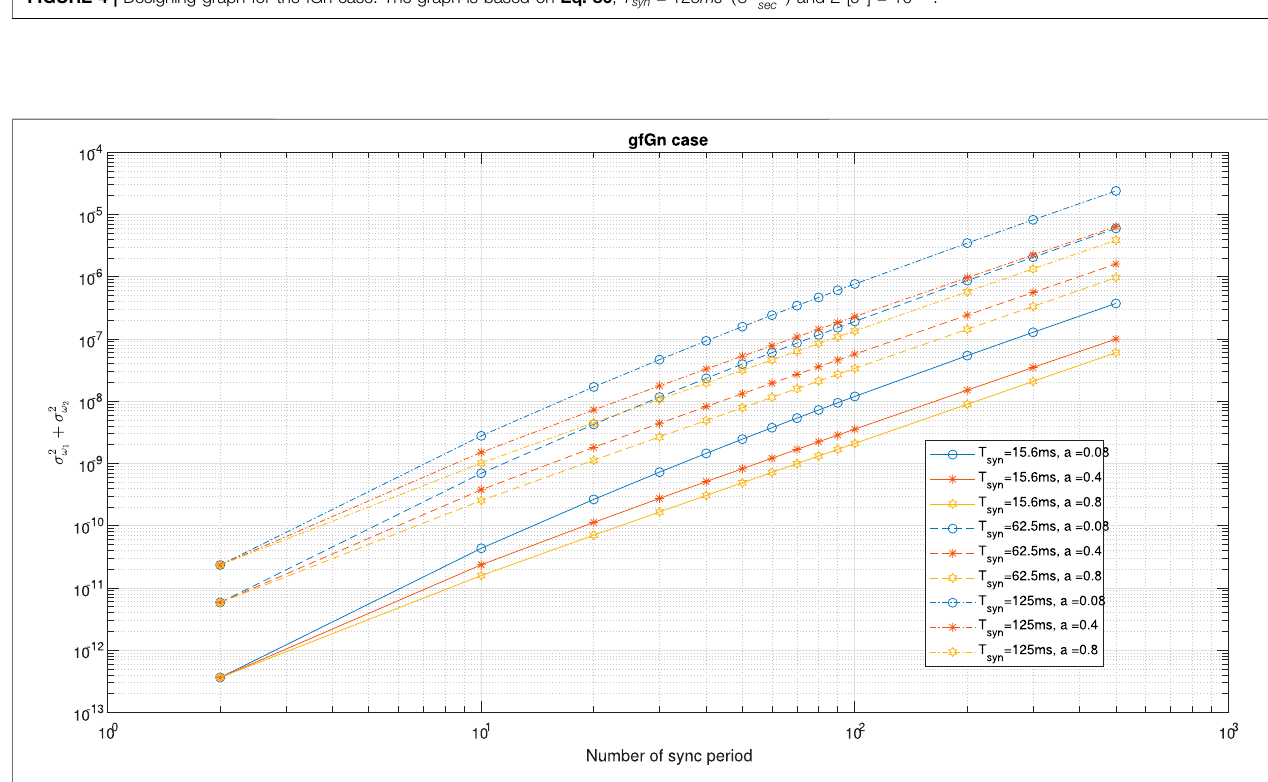
FIGURE 4 | Designing graph for the fGn case. The graph is based on Eq. 86 , T syn (cid:1) 125 ms ( 8 packet